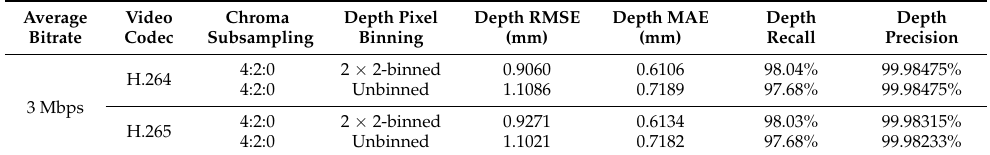
Table 3. Quantitative depth reconstruction results of a still scene of a bust, using both 2 × 2-binned and unbinned depth sensor data. The 2 × 2-binned and unbinned depth sensor recordings are the same as those described in Table 2, with identical preprocessing. In this experiment, 2-pass video encoding was performed with FFmpeg to target an average bitrate of 3 Mbps. All quantitative measures are taken as aggregates over the entire 582-frame videos. All MWD encodings used n stairs = 6 and other settings were as described in the first paragraph of Section